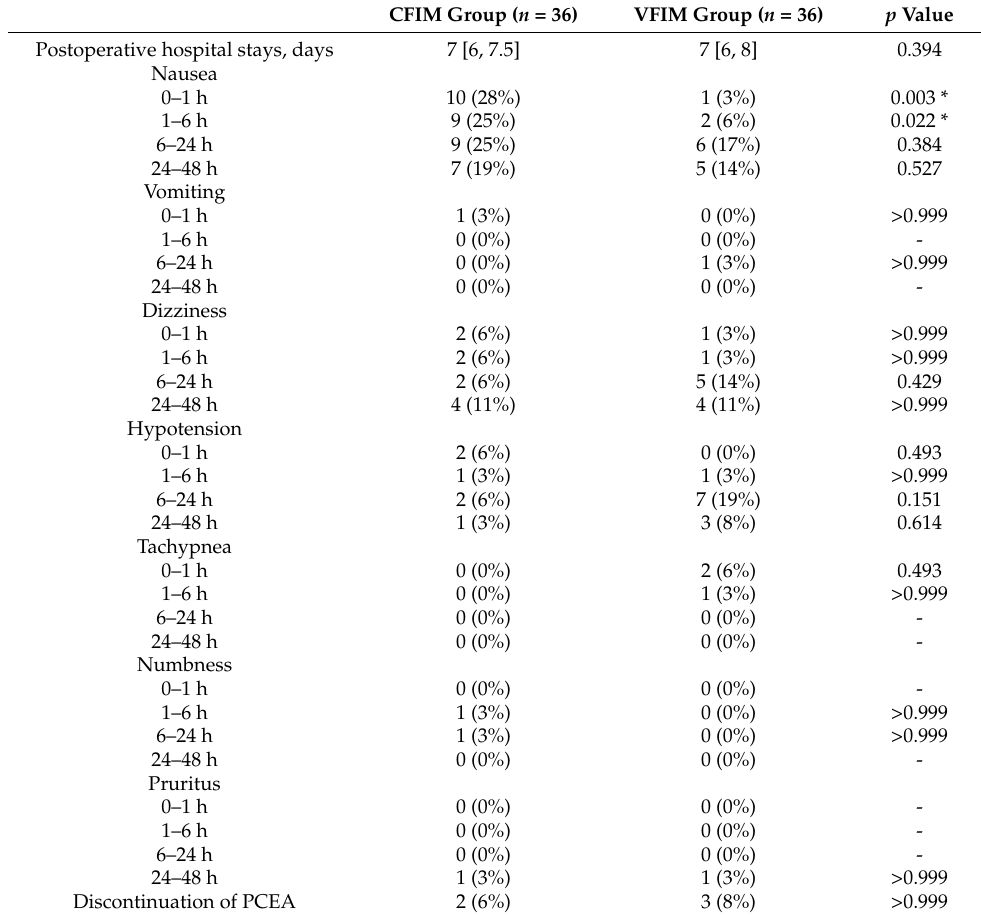
Figure 2. Resting numeric rating score of pain intensity ( A ) and the number of patients who experienced postoperative nausea ( B ). Box plot with median (solid line), interquartile range (box), and values within 1.5 times the interquartile range (whiskers) are shown. * p < 0.05. NRS, numeric rating score; CFIM, conventional fixed-rate infusion mode; VFIM, variable-rate feedback infusion mode. Table 3. Postoperative adverse effects up to 48 h after